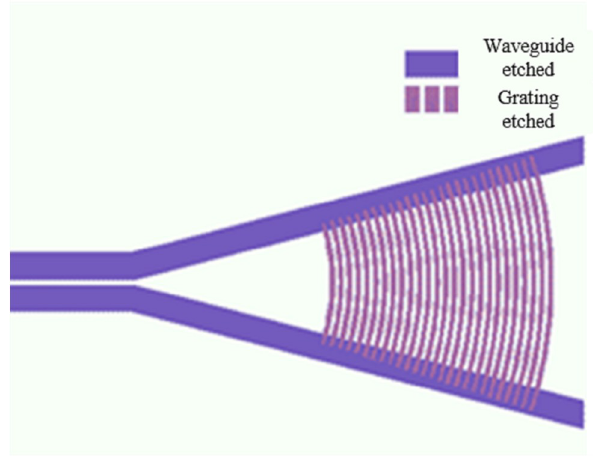
Figure 1. Mask design of silicon optical waveguide.